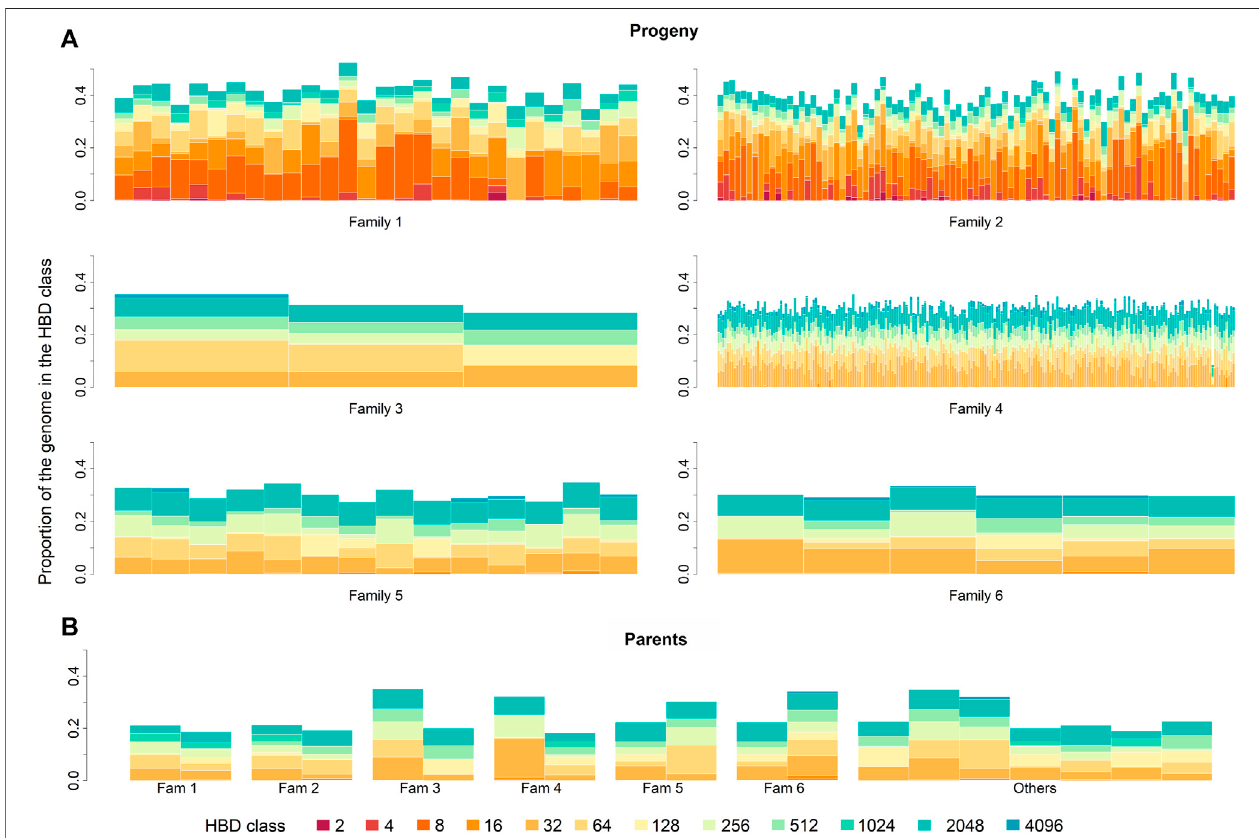
FIGURE 1 | Partitioning of the genome in different homozygous-by-descent (HBD) classes for progeny (A) and parental (B) generation. Progeny generation is shown family-wise. Parental generation is separated by parents of each family. Family 5 and 6 built one paternal half-sib family. The height of the bar represents the proportion of the genome associated with the HBD class of the corresponding